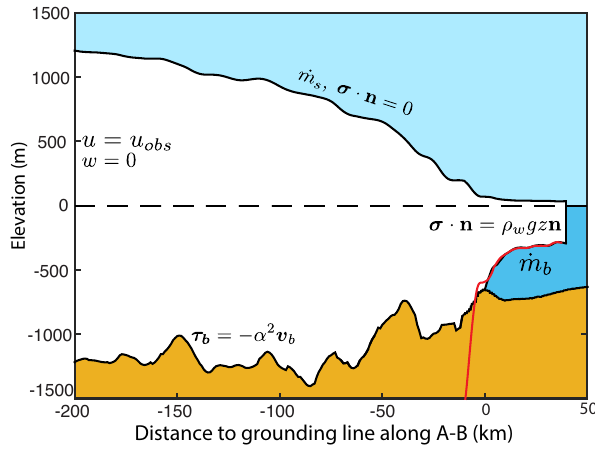
Figure 3. Geometry of the selected flow line AB and boundary con- ditions of the model. The black lines are ice surface elevation, ice bottom elevation and bed elevation. The red line is the hydrostatic bottom elevation calculated from surface